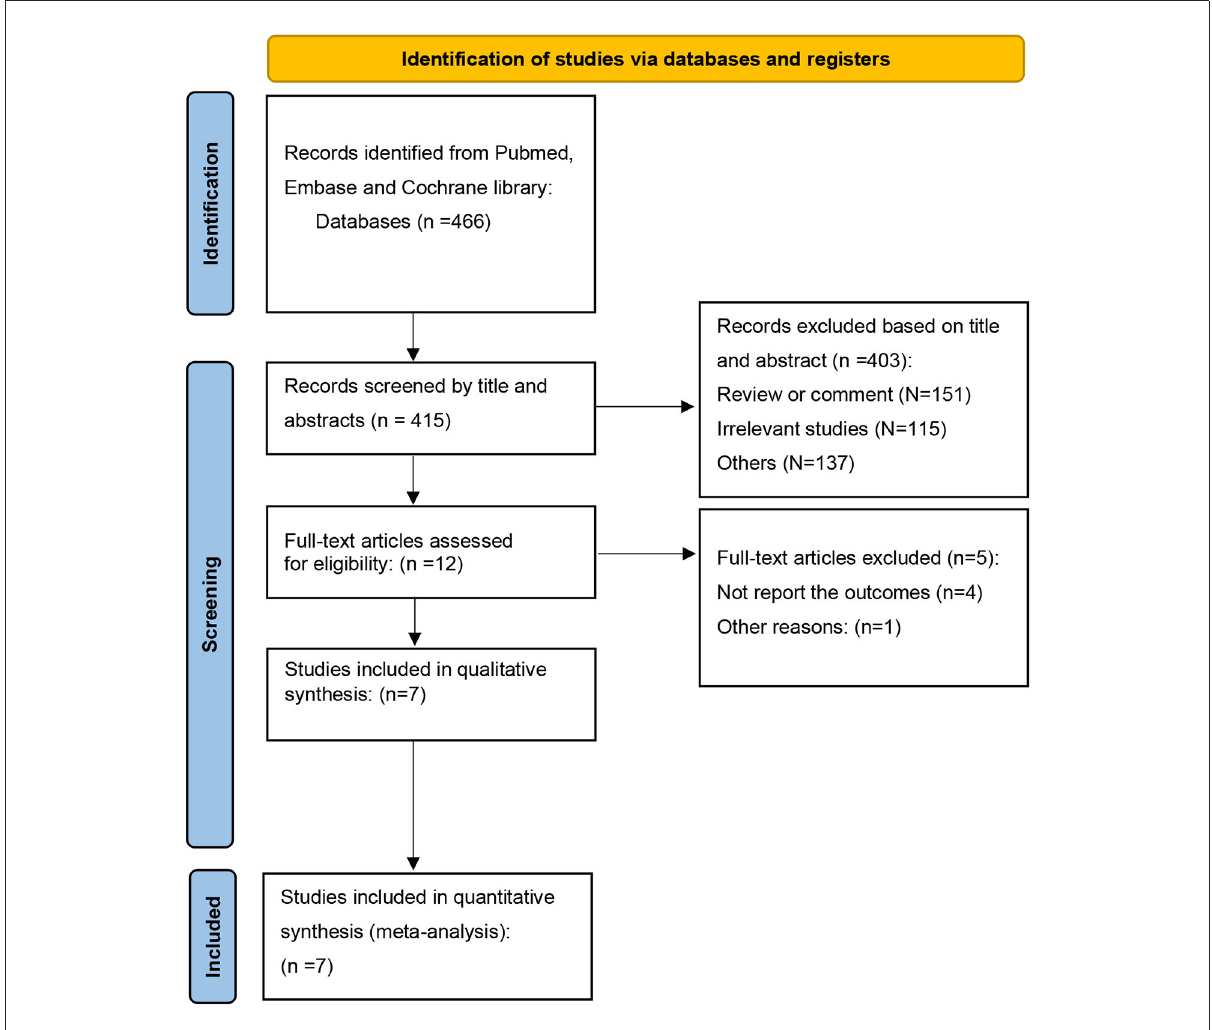
FIGURE1 PRISMA search strategy.